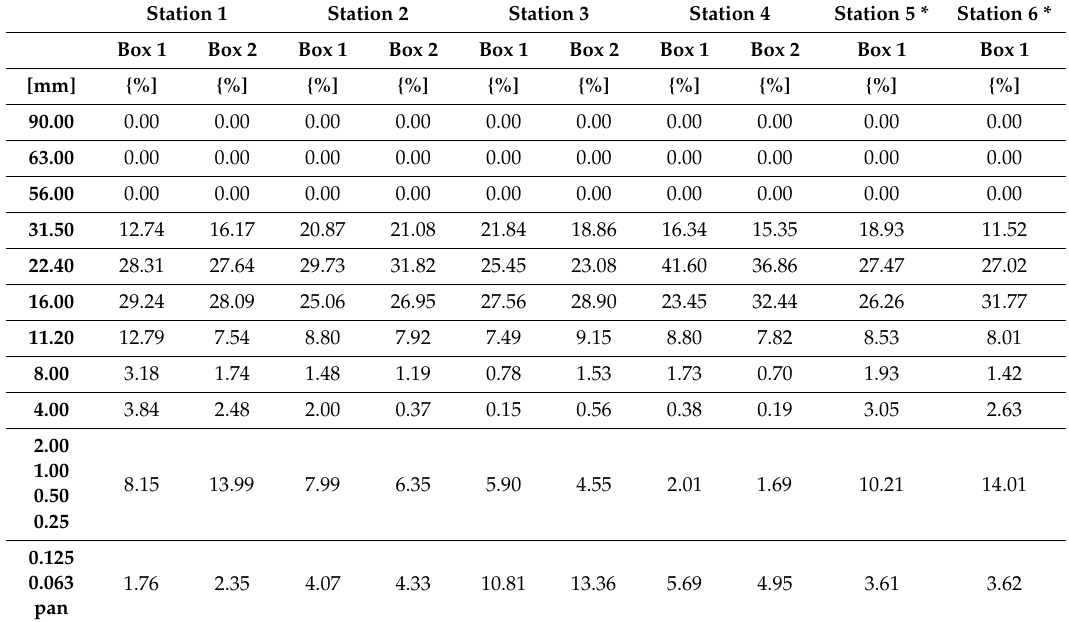
Table 3. Analysis of sediment samples taken from the sediment boxes at the breeding